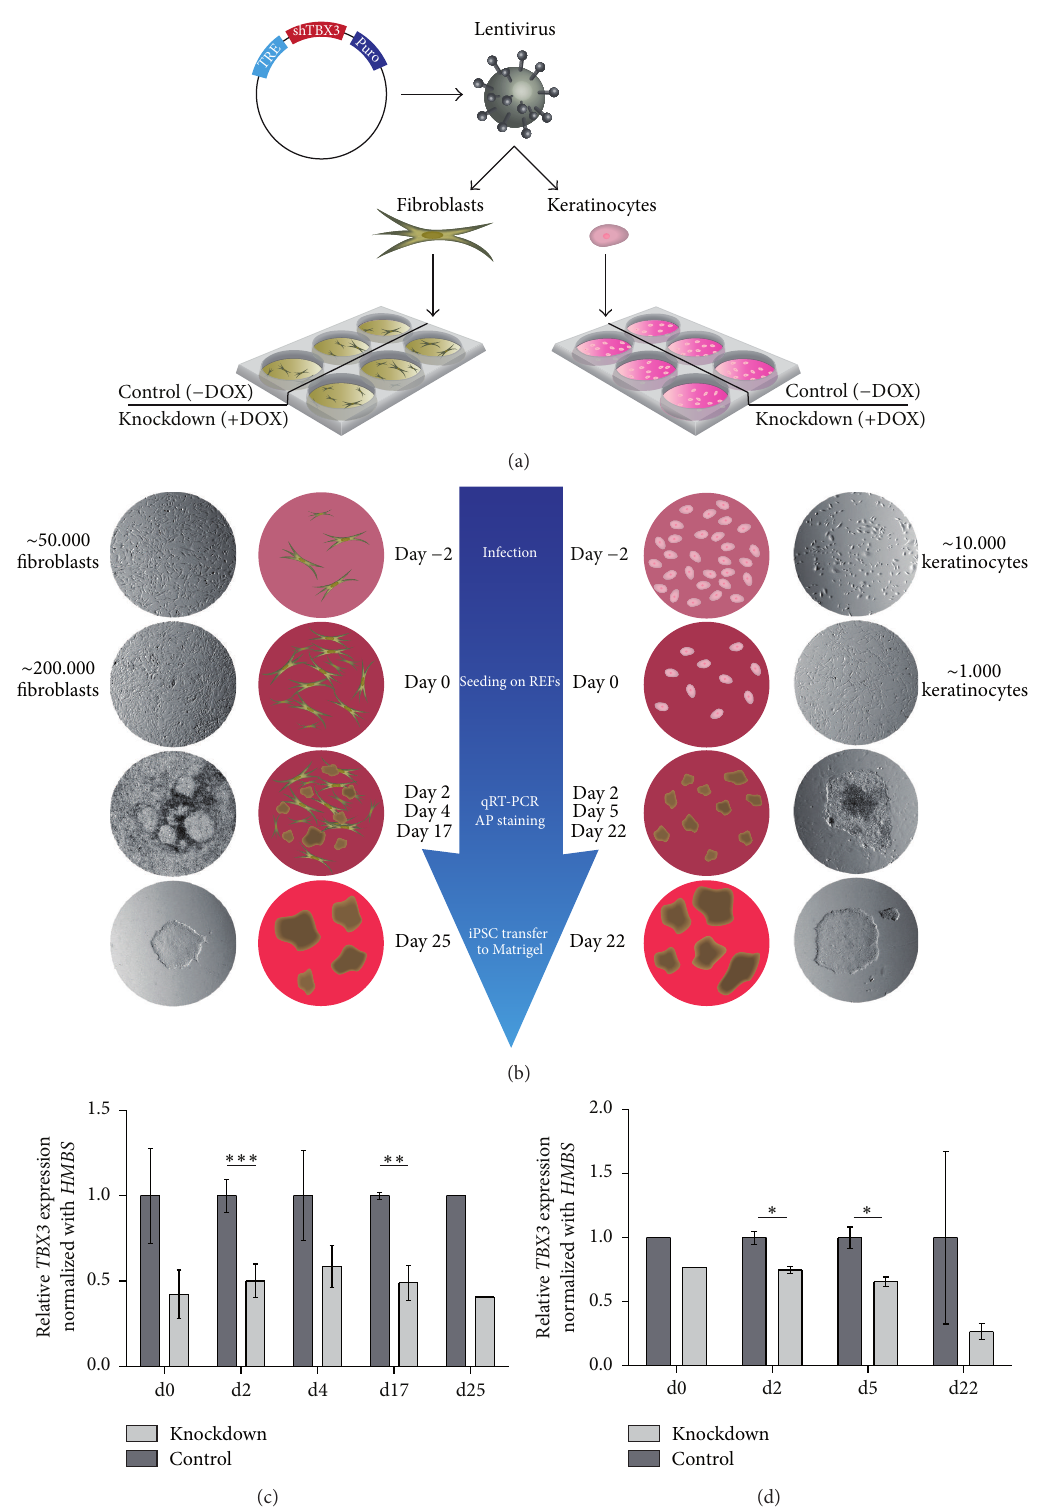
Figure 1: Reprogramming fibroblasts and keratinocytes with a TBX3 knockdown. (a) Infection of fibroblasts and keratinocytes with a TRIPZ Human TBX3 shRNA lentivirus, inducible via doxycycline addition. (b) Reprogramming time scheme with fibroblasts (left) and keratinocytes (right) along with starting cell numbers and experiment time points. (c) TBX3 knockdown during reprogramming of fibroblasts at day 0 (seeding infected cells on feeder layer), day 2, day 4, day 17, and day 25 (last day on feeder cells before transfer to feeder-free system on Matrigel). Control is not treated with doxycycline. (d) TBX3 knockdown during reprogramming of keratinocytes at day 0 (seeding infected cells on feeder layer), day 2, day 5, and day 22 (last day on feeder cells before transfer to feeder-free system on Matrigel). Control is not treated with